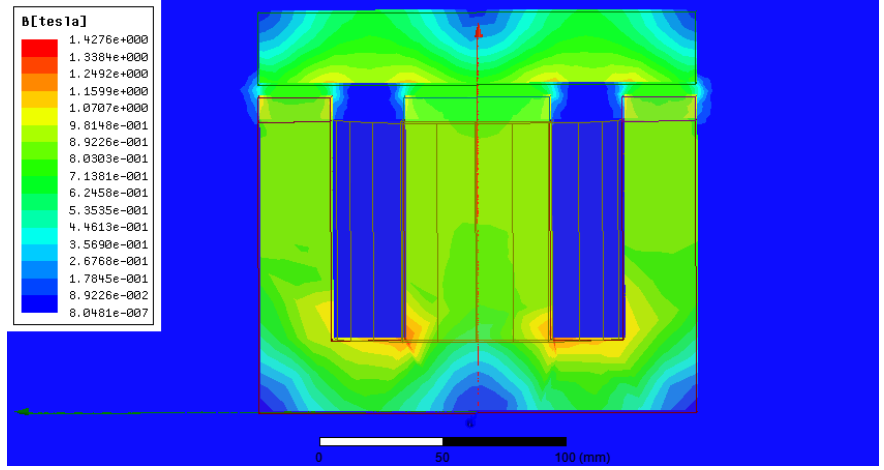
Figure 5. Magnetic flux density of permanent and electromagnet hybrid actuator. Table 3. Attraction force of permanent magnet near working point.